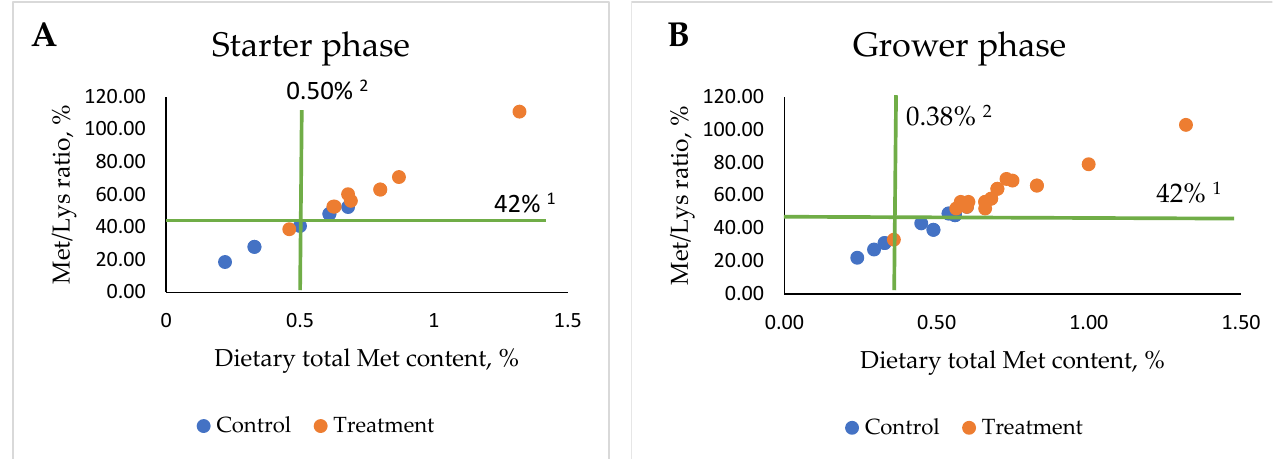
Figure 1. Dietary total Met levels and Met to Lysine ratios used in starter and grower diets from various studies conducted in broilers. ( A ) Relationship of total dietary Met content to Met/Lys ratio in the starter phase of broilers. ( B ) Relationship of total dietary Met content and Met/Lys ratio in the grower phase of broilers. ( 1 NRC 1994 Methionine to Lysine ratio recommendations, 2 NRC 1994 Met recommendation in broilers diet in respective feeding phase).